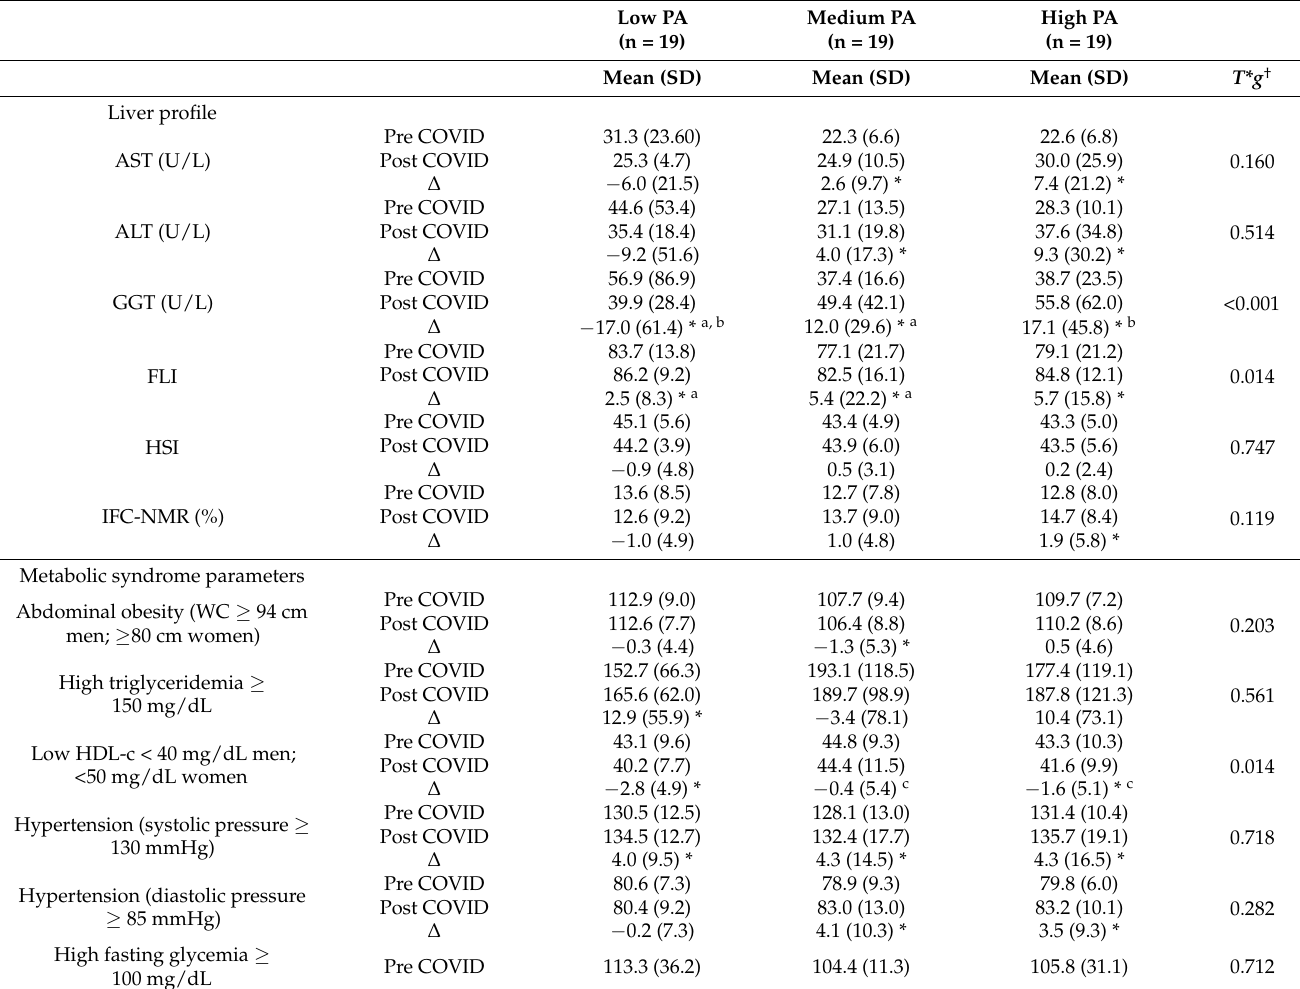
Table 3. Changes in NAFLD parameters within and between PA difference groups pre- and post-